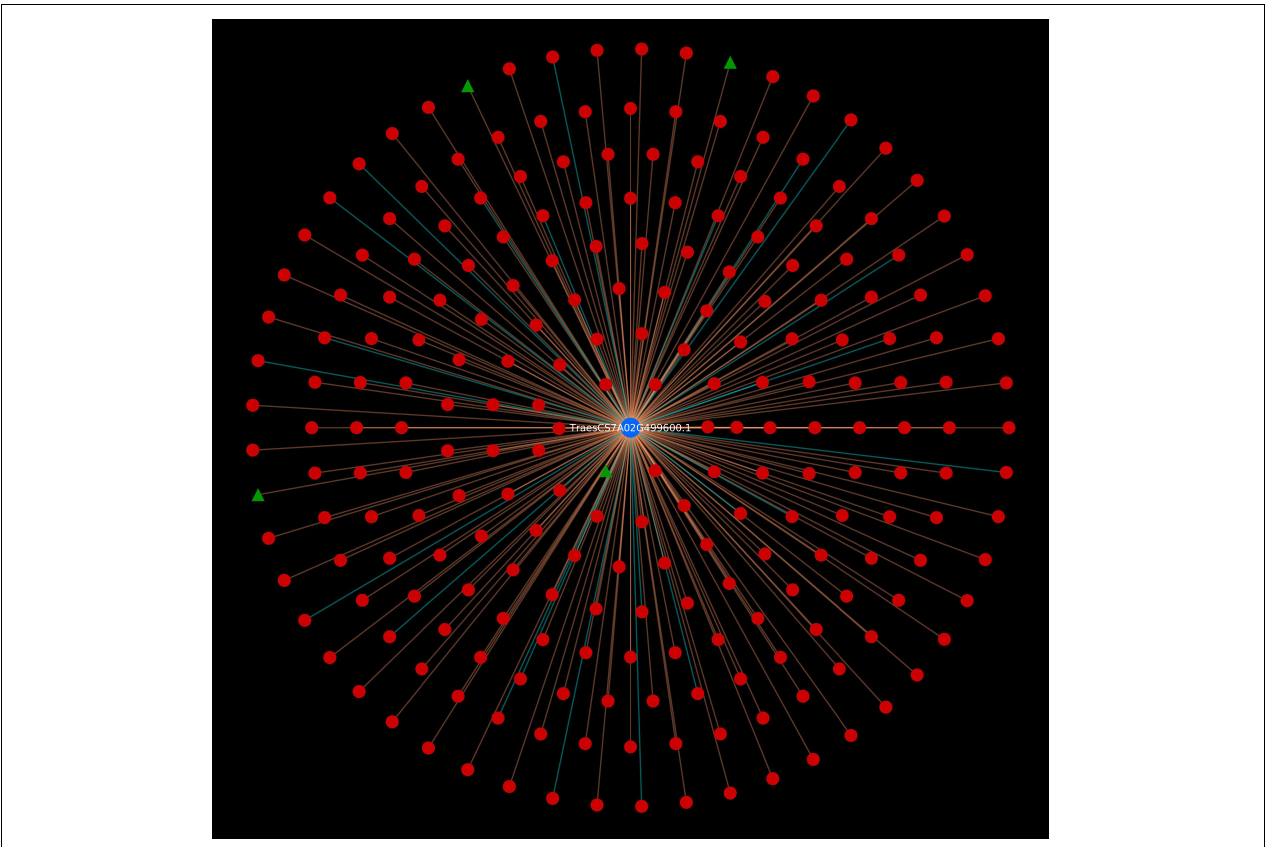
FIGURE 6 | Wheat stem resistance gene Sr22 encoded protein. Blue nodes represent host protein, red nodes are pathogen proteins, and green nodes are effector proteins. Orange edges depict the interactions from interolog-based approach, while cyan edges belong to domain-based